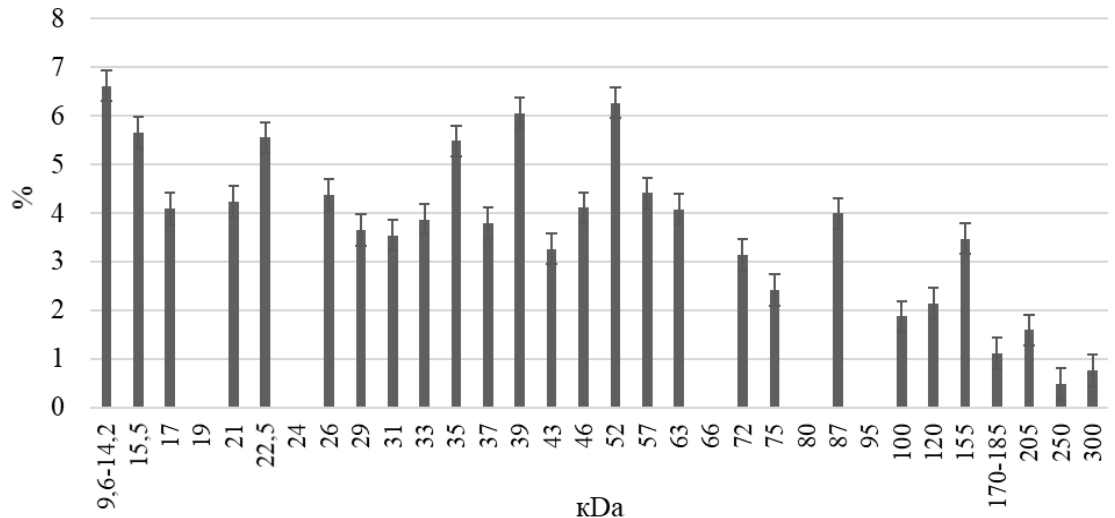
Fig. 3. Structural proteins of the apical membrane of the jejunum enterocytes of four-month-old cattle fetus (M ± m; %; n = 6)